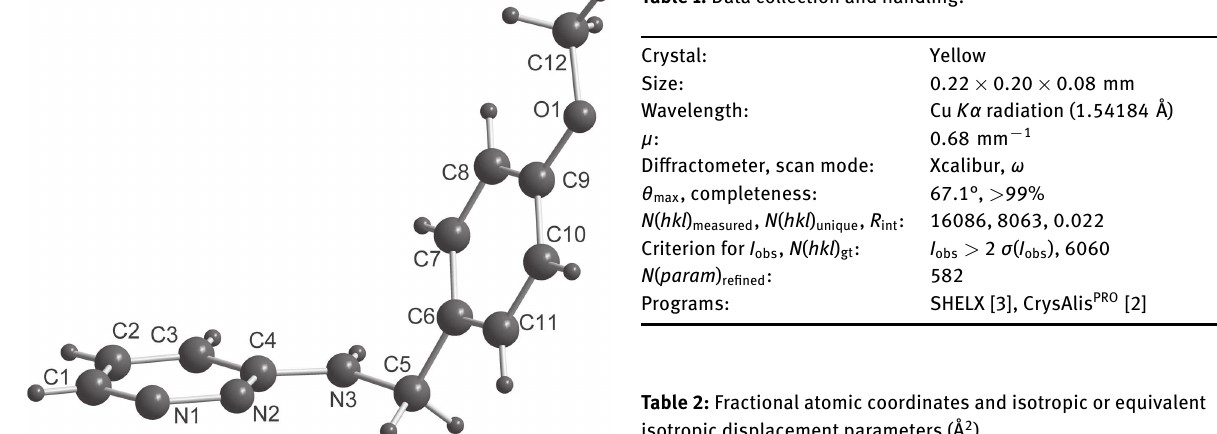
Table 1: Data collection and handling.